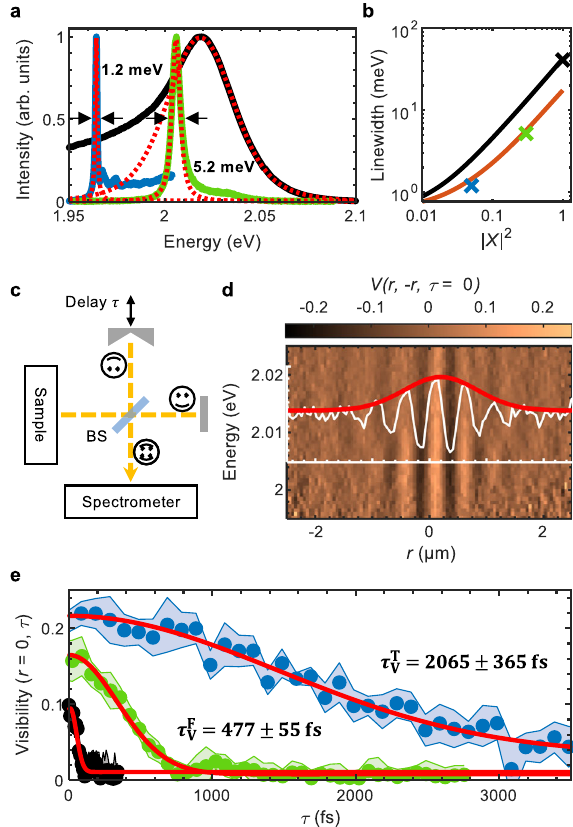
Fig. 3 Linewidth and coherence measurements. a PL spectra at k ∣∣ ≈ 0 of the free polaritons (green), trapped polaritons (blue), and of WS 2 excitons in the bare monolayer on the same substrate (black). The WS 2 exciton spectrum and the polariton ground states were fi tted with a Voigt line pro fi le (red dots). b Theoretical polariton linewidth as a function of excitonic Hop fi eld coef fi cient, based on the WS 2 exciton linewidth (see text) and a cavity mode with the quality factor Q ≈ 3000 (see Methods section), with (black) and without (orange) contribution of inhomogeneous exciton linewidth broadening. Crosses mark the linewidths of the exciton (black) and polariton (green and blue) emissions from the data in panel a . c Schematic of the experimental setup of the modi fi ed Michelson interferometer (see Methods section). d Normalised, spectrally resolved interferogram of the free polaritons at zero time delay (see Methods section) superimposed with the interference fringes at their lowest energy E = 2.004 eV in the range [ − 0.2, 0.2] (white) and the corresponding fringe visibility (red). e Time coherence measurements of the excitons (black data points), free polaritons (green data points), and trapped polaritons (blue data points) at their lowest energies, fi tted with a second order exponential decay function (red lines). The extracted decay times for the fringe visibility ¼ ð 62 ± 15 Þ fs for the excitons, τ F ¼ ð 477 ± 55 Þ fs for the free are τ X V V ¼ ð 2065 ± 365 Þ fs for the trapped polaritons. The shaded polaritons, and τ T V areas correspond to the uncertainties of the fi tting procedure and represent a 95% con fi dence interval. For the measurements in a , d , e , the PL is collected at the position of the excitation